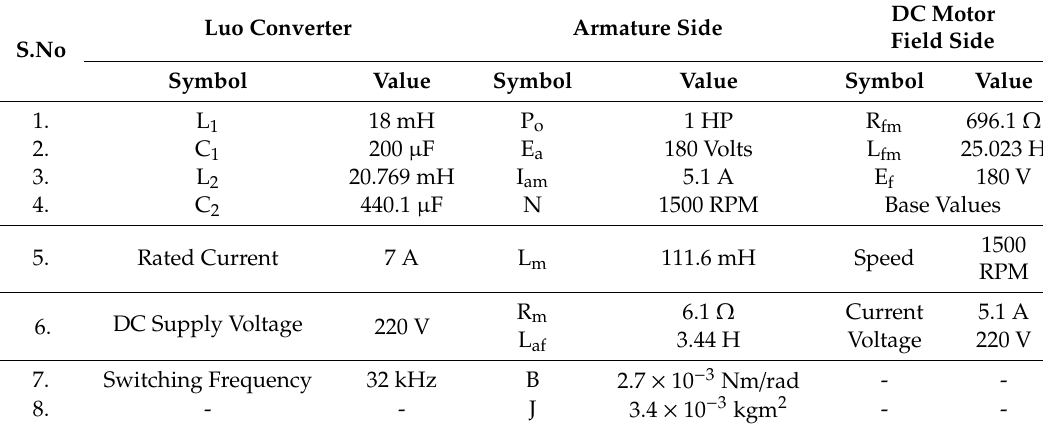
Table 1. Specifications for ETEDPOF control of a Luo converter with dynamic